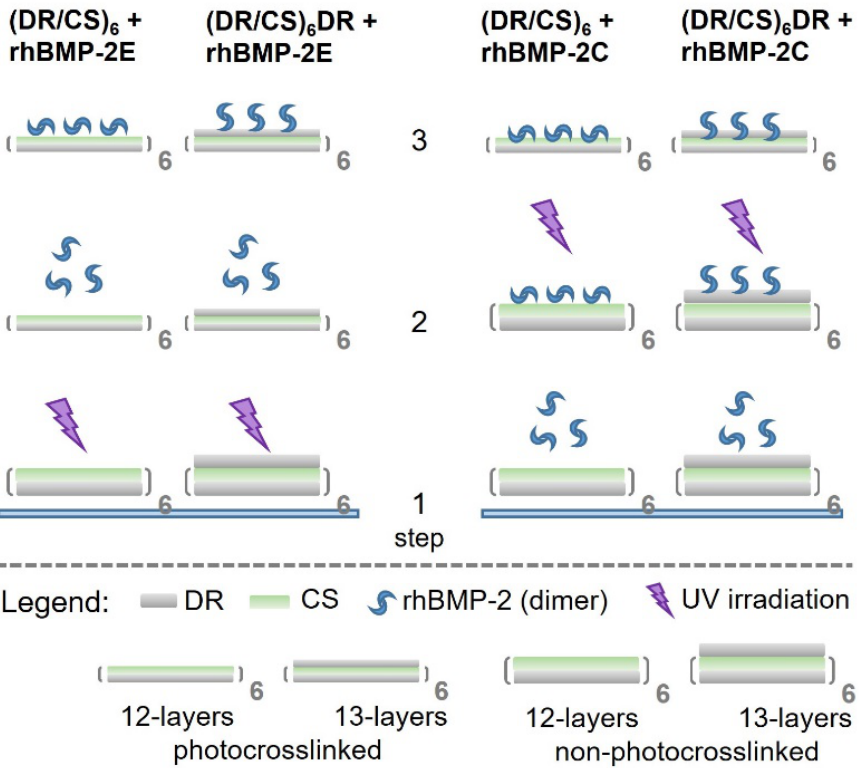
Figure 4. Schematic presentation of the obtained surfaces with preparation steps; E–protein bound electrostatically, C–protein bound covalently. Non-photocrosslinked multilayers are marked as a thicker system, while photocrosslinked layers are thinner. After the photocrosslinking of the multilayers, the rhBMP-2 homodimer was deposited via electrostatic interactions to obtain two systems denoted as (DR/CS) 6 + rhBMP-2E and (DR/CS) 6 DR + rhBMP-2E (Figure 4, step 2 left side). When the rhBMP-2 homodimer was deposited via electrostatic interactions with the surface followed by photocrosslinking, two other systems were obtained, denoted as (DR/CS) 6 + rhBMP-2C and (DR/CS) 6 DR + rhBMP-2C (Figure 4, step 2 right side). Thus, four systems were obtained based on the physical (E) and chemical (C) immobilization of rhBMP-2 on both surfaces. TOF-SIMS with multivariate principal component data analysis was used to study the differences in rhBMP-2 interactions within the topmost layers. TOF-SIMS is an attractive technique because of its sensitivity to the outermost region of the surface. The SIMS sampling depth is smaller (~1–2 nm) than the size of the molecules of most proteins, so the differences in the proteins’ state (orientation, conformation) can be examined [36]. This technique evaluated the protein surface coverage in our research and was used to analyse the protein state. The multivariate principal component data analysis allowed the investigation of the protein orientation and conformation regarding exposed amino acids [37]. The main source of the variability of the TOF-SIMS intensities in the analyzed dataset, captured by the first principal component (PC1) at 95.88% (describing most of the total variance), was related to the protein surface coverage (Figure 5A). The second principal component (PC2), capturing 2.27% of the variance, separated samples with different protein states (Figure 5B). The score plot (PC2 vs. PC1) for the developed PCA model obtained for all proteins’